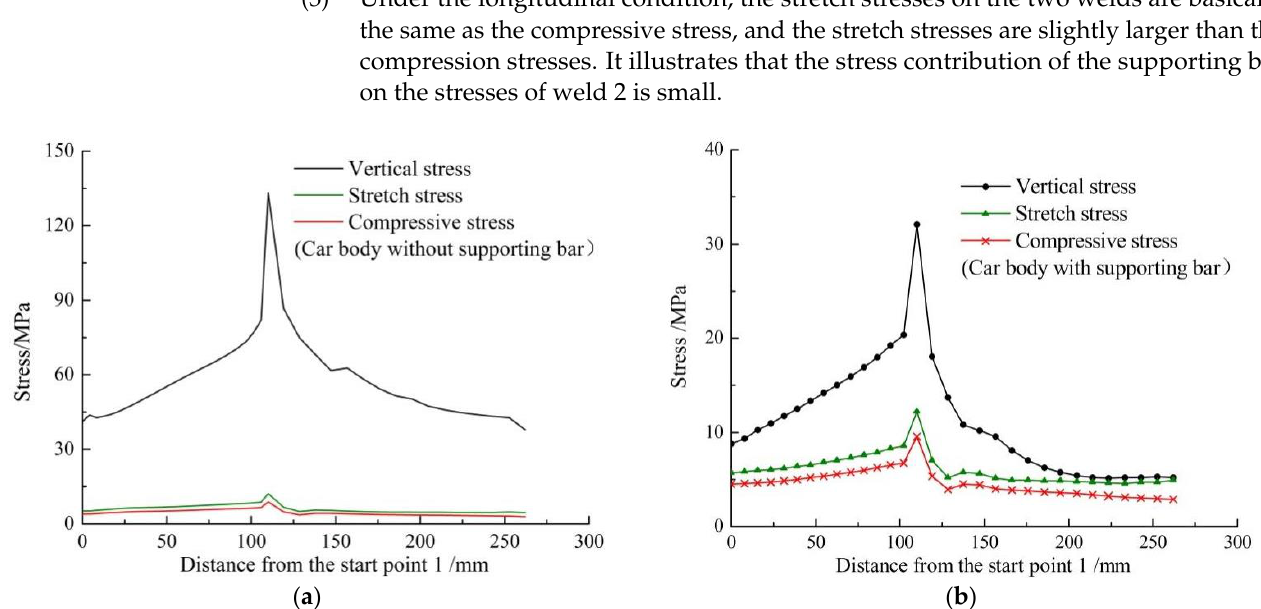
Figure 7. The stress distribution of weld 1. ( a ) Scheme 1, ( b ) scheme 2.